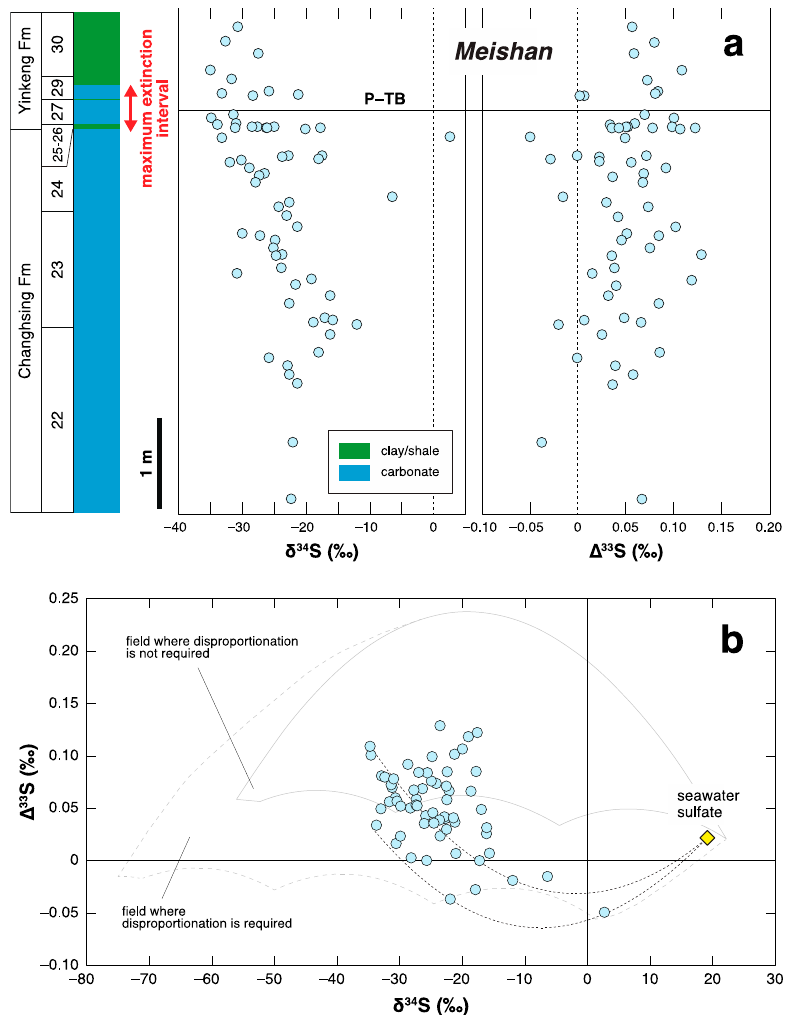
Figure 2. Multiple sulfur isotope record across the Permian-Triassic boundary (P-TB) at Meishan [55]. ( a ) sulfur isotope chemostratigraphy. A number along the log is Bed number. The maximum extinction interval is from Shen S.Z. et al. [2]. Fm: Formation; ( b ) δ 34 S– ∆ 33 S cross plot modified from Shen Y. et al. [55]. Most of the data with positive ∆ 33 S can be explained by microbial sulfate reduction (MSR) in sulfate-enriched sediments with burrows and/or disproportionation of sulfur intermediate compounds. In contrast, some negative ∆ 33 S values suggested the addition of 34 S-enriched sulfide (diamond) to the sediments, although fields where disproportionation were required and not required (dashed and solid umbrellas, respectively) were expanded later by Zhang et al. [67] and the 34 S-enriched sulfide’s participation in the sediments with negative ∆ 33 S value became unclear. Shen Y. et al. [55] interpreted that the 34 S-enriched sulfide was produced via quantitative reduction of porewater sulfate in the closed sediments with the absence of bioturbation, and that its δ 34 S and ∆ 33 S values were identical to the values of contemporaneous seawater sulfate (+19.2‰ and +0.022‰, respectively) [68]. A convex downward curve is a possible mixing trend. Shen Y. et al. further inferred that shoaling of anoxic deep-water onto the shelf reduced the benthos activity and led to the production of 34 S-enriched sulfide in the